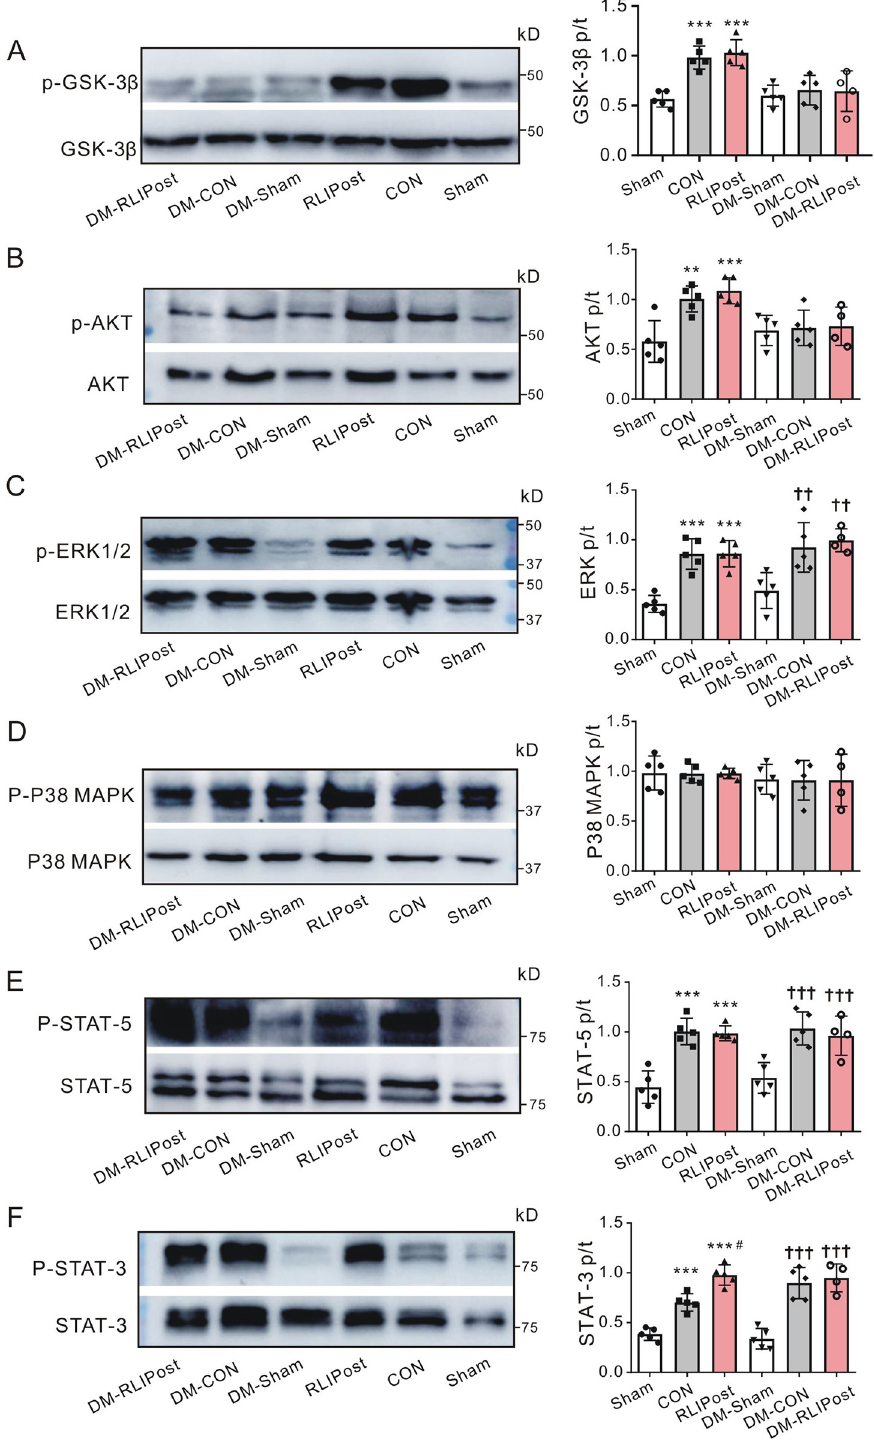
Fig 7. The effect of RLIPost on pulmonary STAT-3 phosphorylation post I/R. Left , Representative Western blots of phospho-(p) GSK-3 β and total (t) GSK-3 β ( A ), phospho-(p) AKT and total (t) AKT ( B ), phospho-(p) ERK1/2 and total (t) ERK1/2 ( C ), phospho-(p) P38-MAPK and total (t) P38-MAPK ( D ), phospho-(p) STAT-5 and total (t) STAT-5 ( E ) and phospho-(p) STAT-3 and total (t) STAT-3 ( F ) in rat lungs after I/R injury. sham: sham-operated, CON: control, RLIPost: remote liver ischemia postconditioning, DM: STZ-induced diabetes. Right , quantification of the p-GSK-3 β /t-